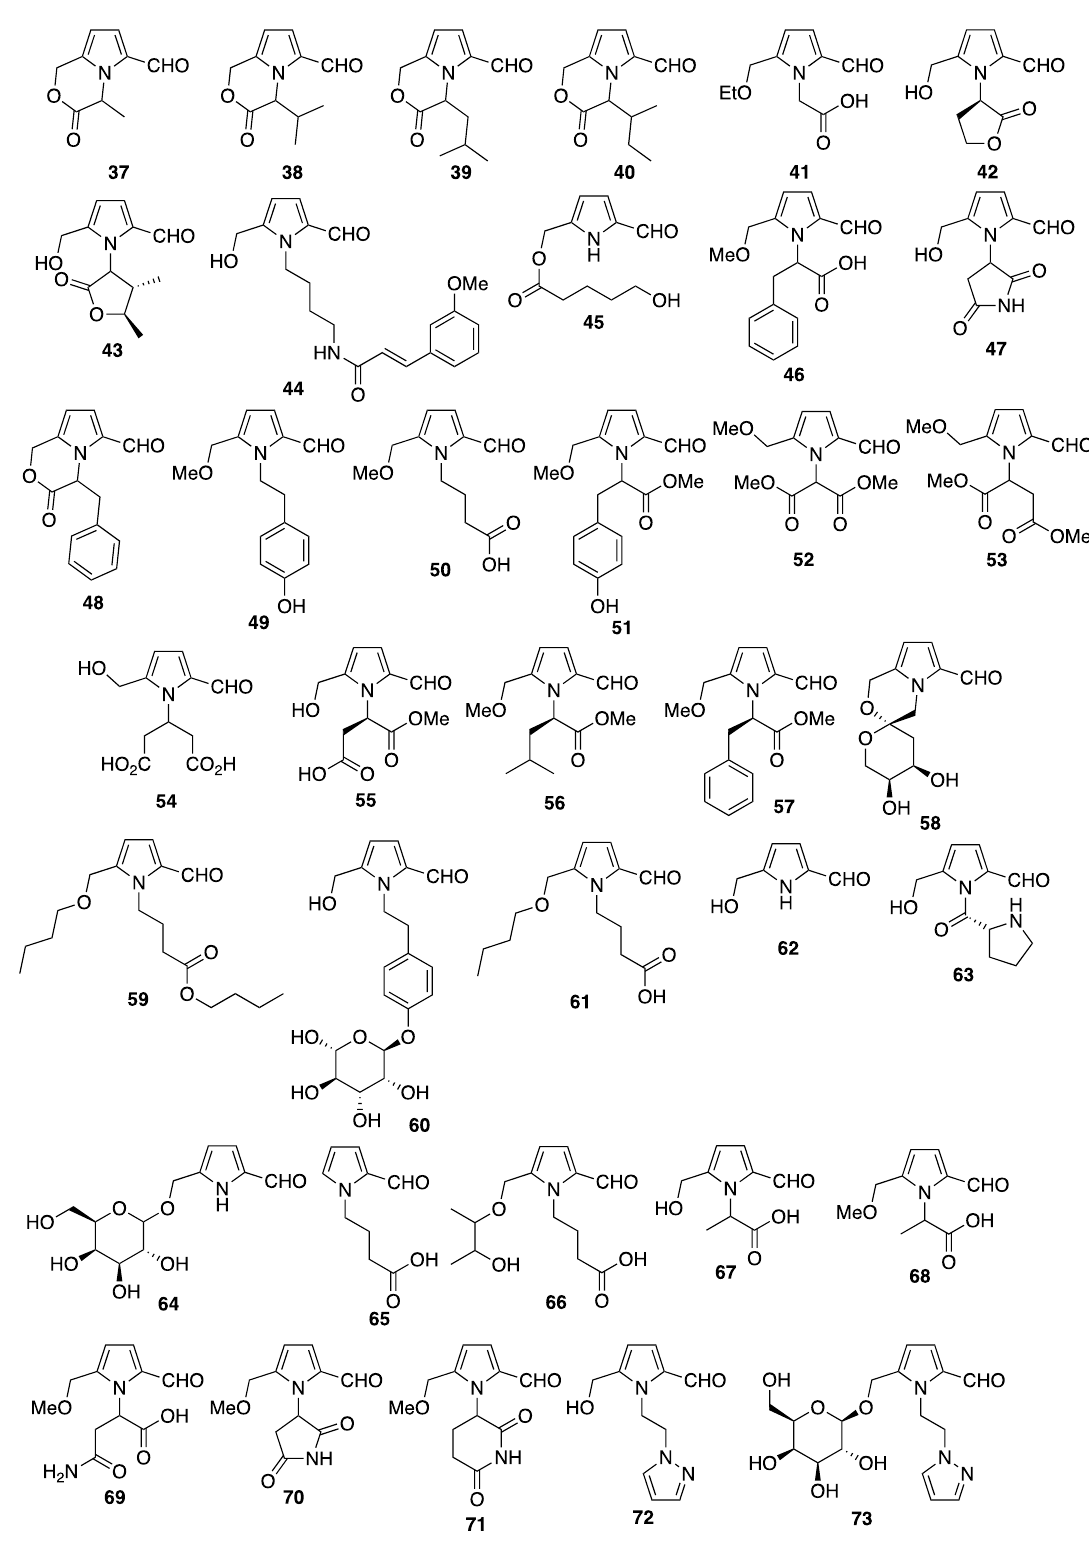
Figure 3. Structures of Py-2-Cs from plant sources. From the fruit of Capparis pinosa , two new Py-2-C derivatives — capparisine A ( 18 ) and capparisine B ( 58 ) — were isolated, along with the known Py-2-C derivatives 2-(5-hy- droxymethyl-2-formyl-1-yl) α -methyl-acetic acid lactone ( 37 ) and N -( 3′ -maleimidyl)-5-hy- droxymethyl-2-pyrrole formaldehyde] ( 47 ) [49]. From bee-collected Brassica campestris pollen, pollenpyrrosides A ( 17 ) and B ( 18 ) were isolated, and the precise structures were determined using several spectroscopic analysis techniques (NMR, UV, IR, MS, and X- ray) and chemical evidence [63]. Pollenpyrroside A and caparisine B are diastereomers of the same spiroketal alkaloid. The total synthesis of these compounds has been reported, which started with D -fructose as a chiral substrate followed by microwave-assisted